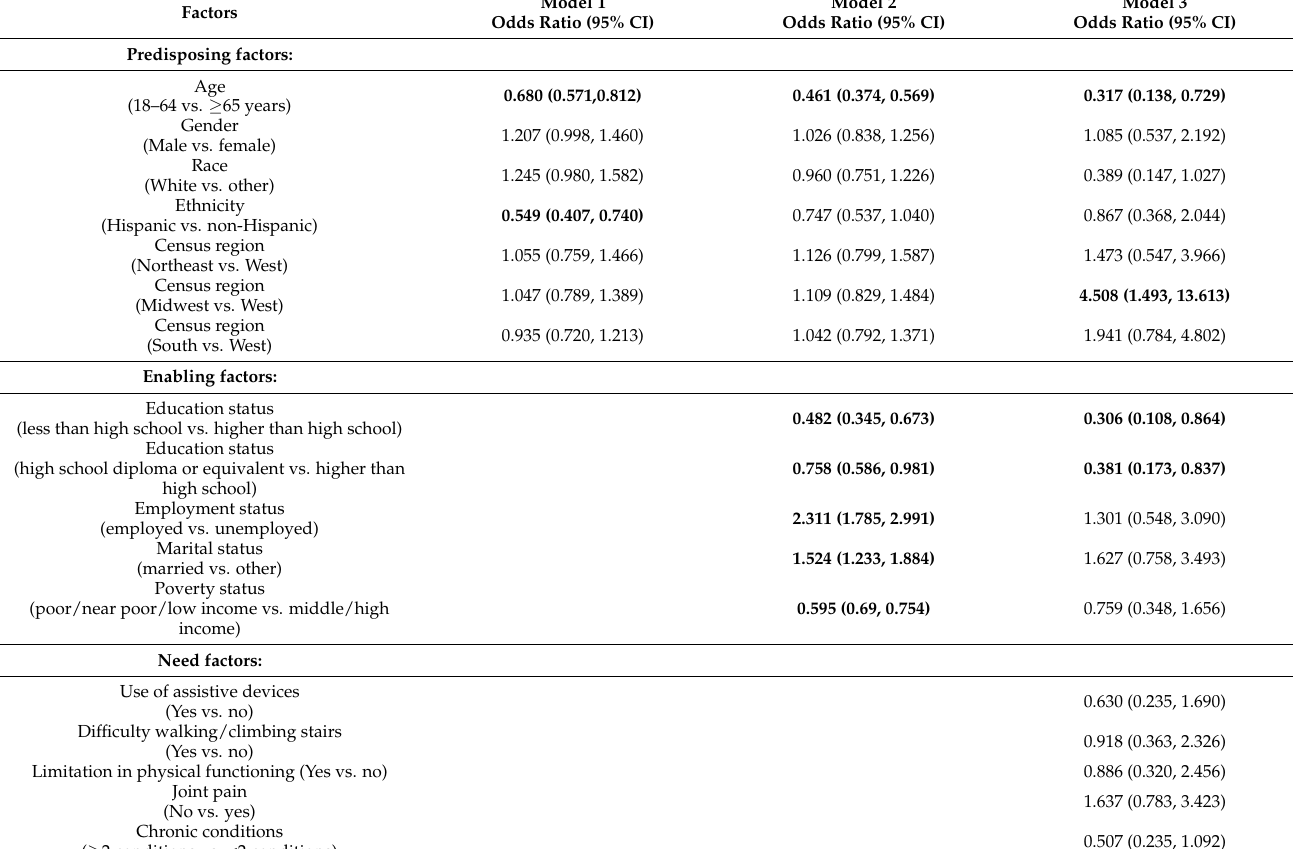
Table 2. Factors associated with good self-perceived mental health among United States adults ( ≥ 18 years) with